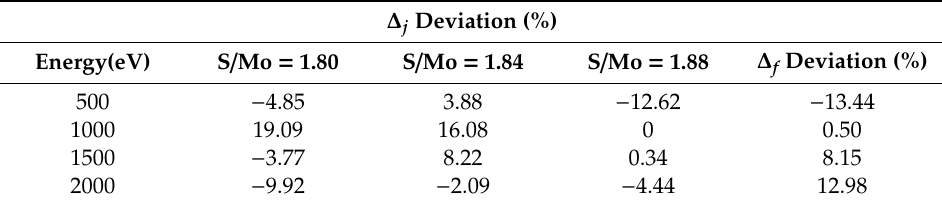
Table 2. The percentage deviations ∆ j and ∆ f , calculated from Equations (8) and (10) for the considered Mo disulfide stoichiometries (in S / Mo AC ratios) and electron energies. Two final rows show the resulting mean percentage deviations R j and R f , calculated from Equations (9) and (11), for the considered surface stoichiometries and electron energies. ∆ j Deviation (%) Energy(eV) S / Mo = 1.80 S / Mo = 1.84 S / Mo = 1.88 ∆ f Deviation